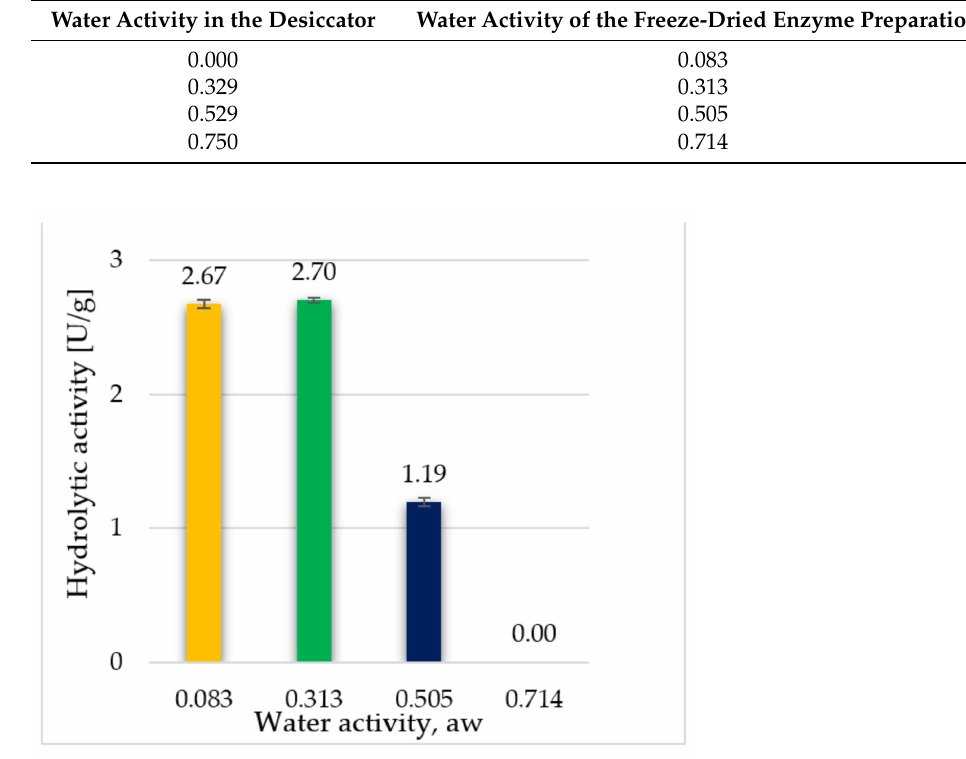
Figure 2. Influence of water activity (a w ) on the hydrolytic activity of freeze-dried enzyme prepara- tions with the addition of 1% ammonium sulphate. Experiments were performed in